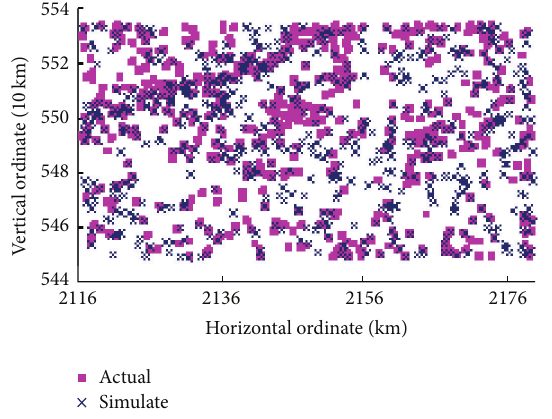
Figure 6: The spatial distribution of